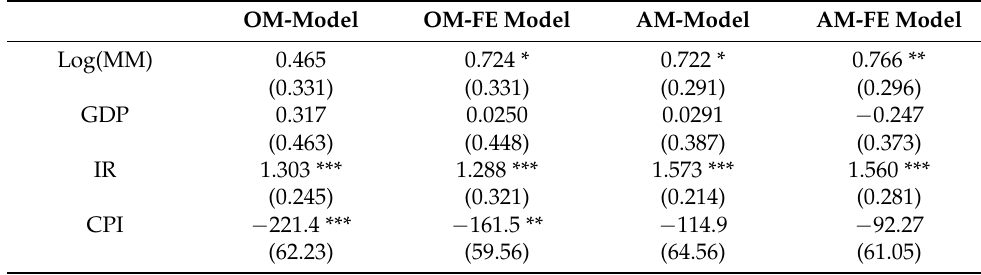
Table A10. Panel Regression OM-Fixed-Effects and AM-Fixed-Effects Models